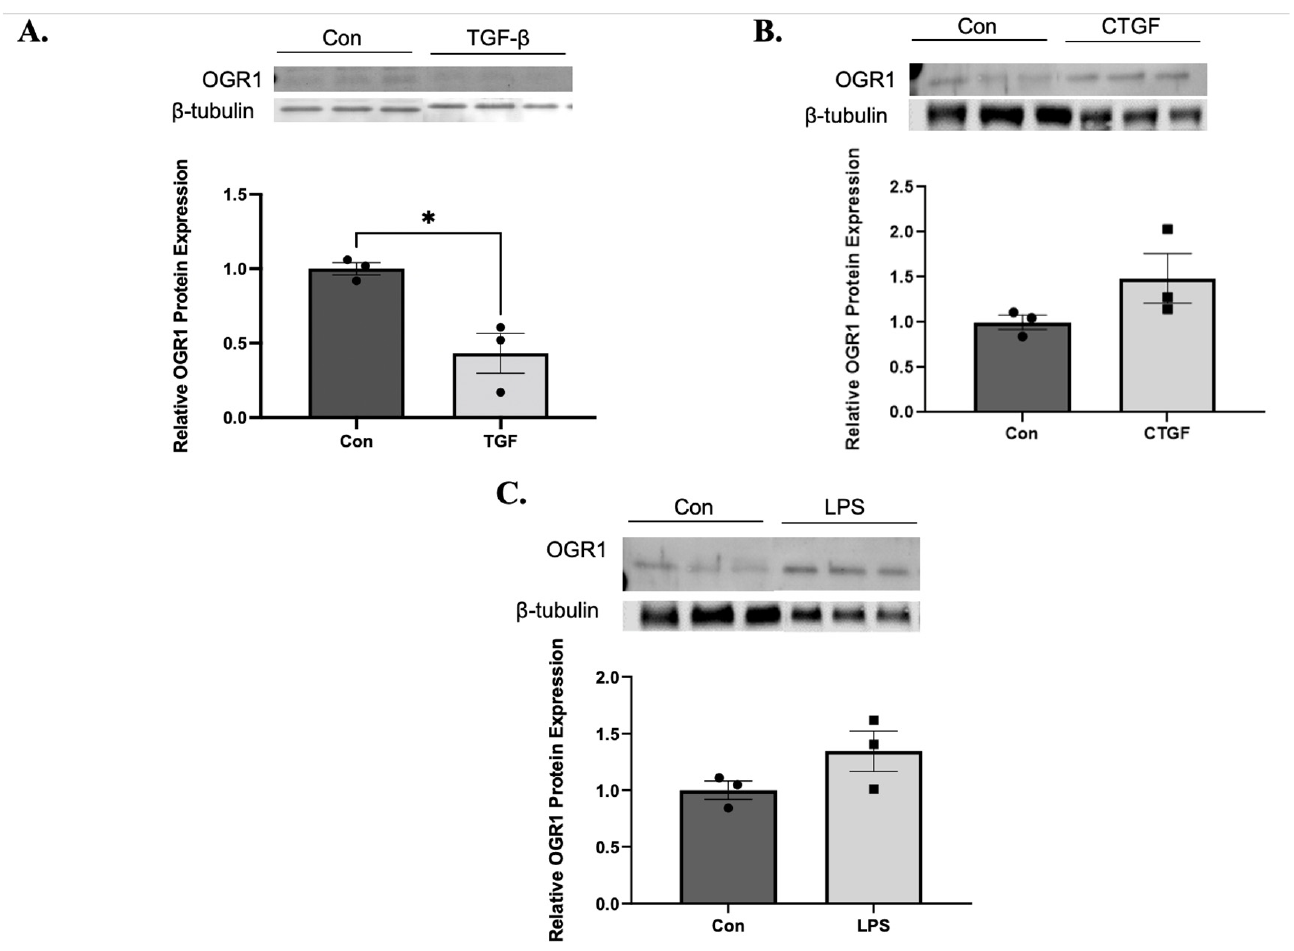
Figure 3. TGF- β , but not CTGF or LPS, reduce OGR1 protein expression. Fibroblasts derived from healthy subjects treated with TGF- β 1 (1 ng/mL), CTGF (0.5 µL/mL), or LPS (0.02 µL/mL) for 48 h, and protein was then harvested. Western blotting was performed to assess for changes in OGR1 expression. As previously demonstrated, TGF- β 1 caused a significant reduction in OGR1 expression ( A ). However, there were no significant differences when fibroblasts were treated with CTGF ( B ) or LPS ( C ). Densitometry analysis is included below each representative western blot and data represent mean expression ± SEM, * p = 0.0155.